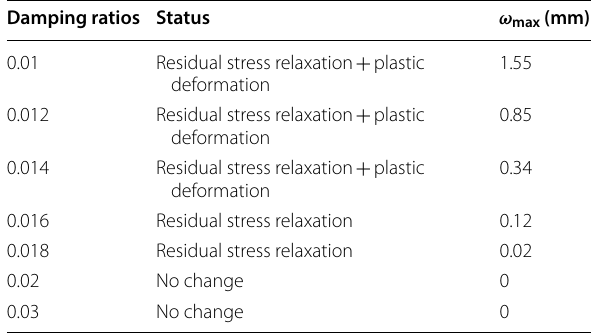
Table 10 Deflections of the long stringer under